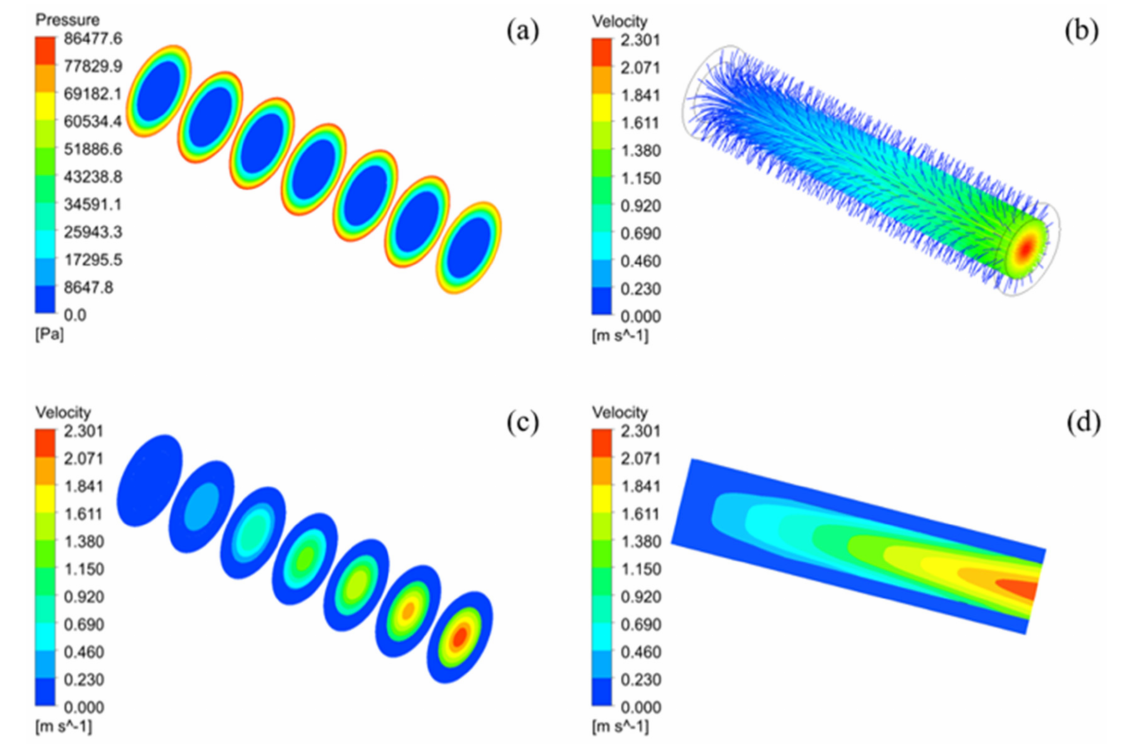
Figure 9. Pressure, flow field and velocity distribution in the fluid domain model: ( a ) pressure distribution, ( b ) flow field, and ( c , d ) velocity